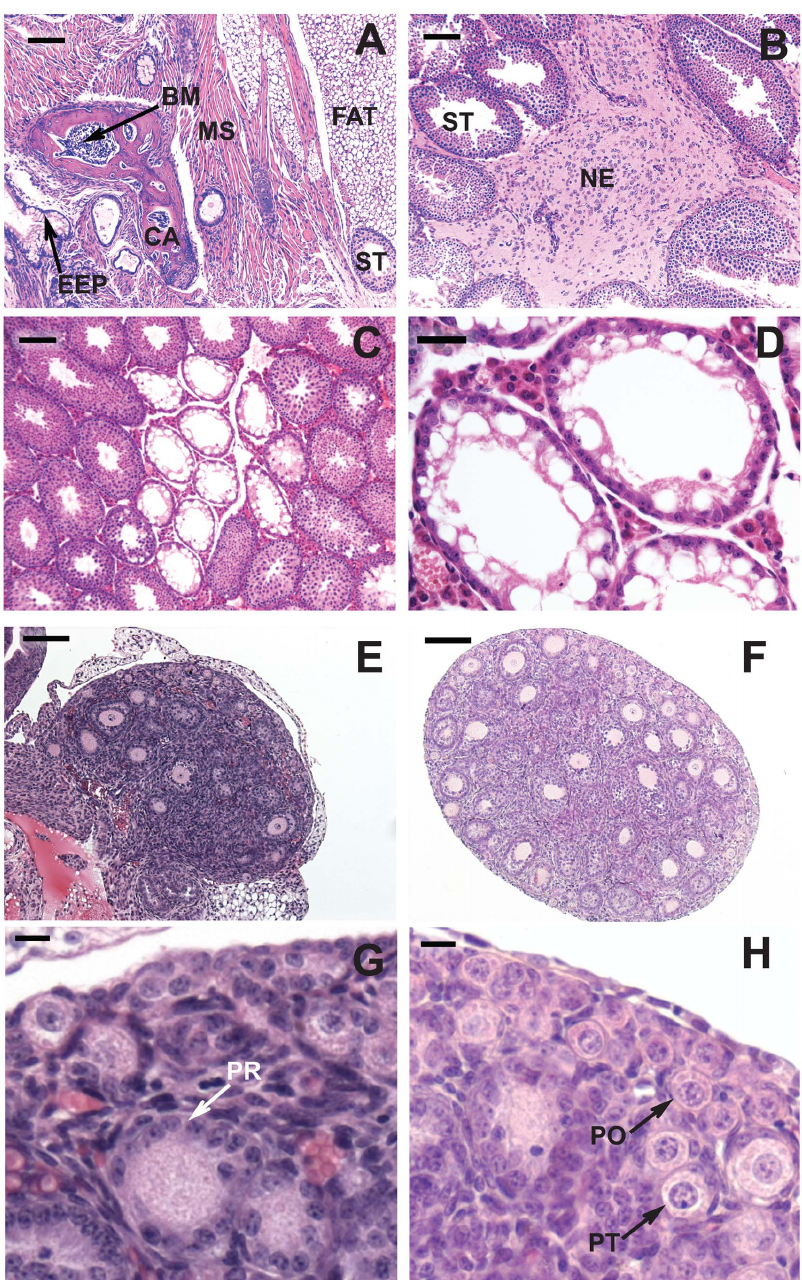
Figure 1. Histology of testes and ovaries from 129 mice exposed to cyclophosphamide at 7.5 mg/kg/day on E10.5 and 11.5. (A-D) Testes from 4-week-old mice. (A) TGCT characterized as a teratoma originating from multiple dermal layers; (B) TGCT containing only neuroepithelial cells. Abbreviations: BM: bone marrow; CA: cartilage; EEP: endodermal epithelium; NE: neuroepithelial cells; MS: muscle; ST: seminiferous tubule. (C) non-TGCT-bearing testis showing active and atrophic tubules. (D) High magnification of atrophic tubules containing only Sertoli cells. (E-H) Ovaries from 7-day-old mice. (E, G) From a mouse treated on E10.5 and 11.5 with 7.5 mg CP/kg/day. (F, H) Control ovary of the same age. G and H are the magnified views from portions of E and F respectively, showing primordial (PO), primary-transitional (PT) and primary (PR) follicles. The bar represents 100 m m in A, B, C, E & F; 30 m m in D; 10 m m in G and H.